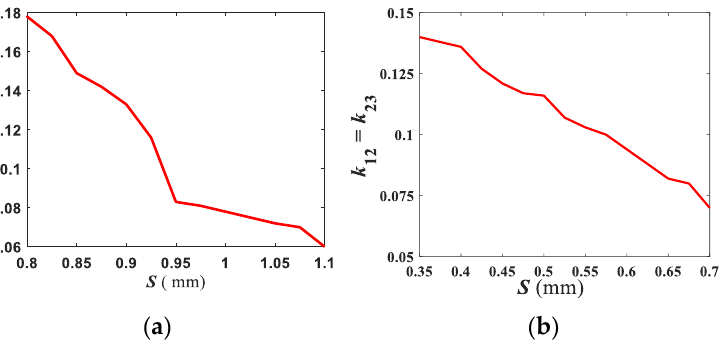
Figure 4. Variation of mutual coupling due to the space between adjacent resonators of UTL IBPF at ( a ) (3.7–4.2 GHz) and ( b ) (5.975–7.125 GHz).